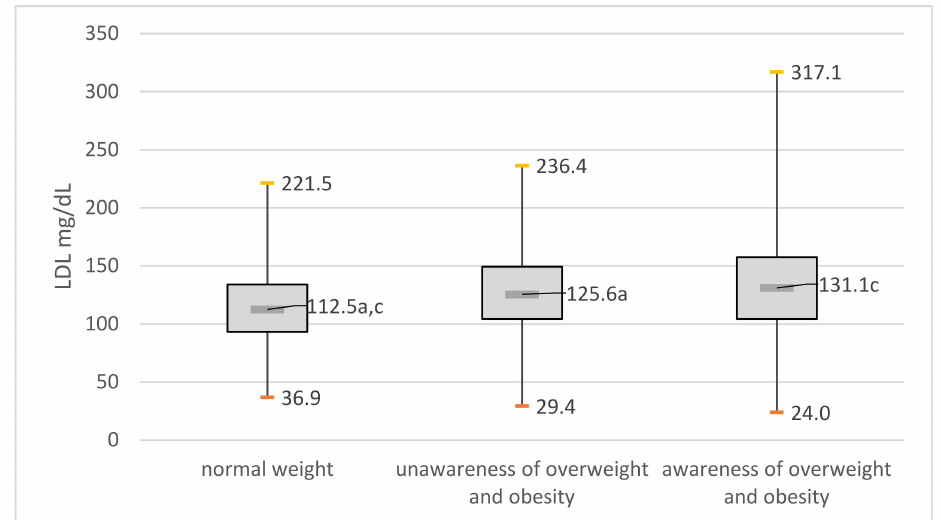
Figure 2. Low-density lipoprotein (LDL) in the compared groups: (a) significant difference between group with normal weight and group unaware of overweight and obesity; (c) significant difference between group normal weight and group aware of their overweight and